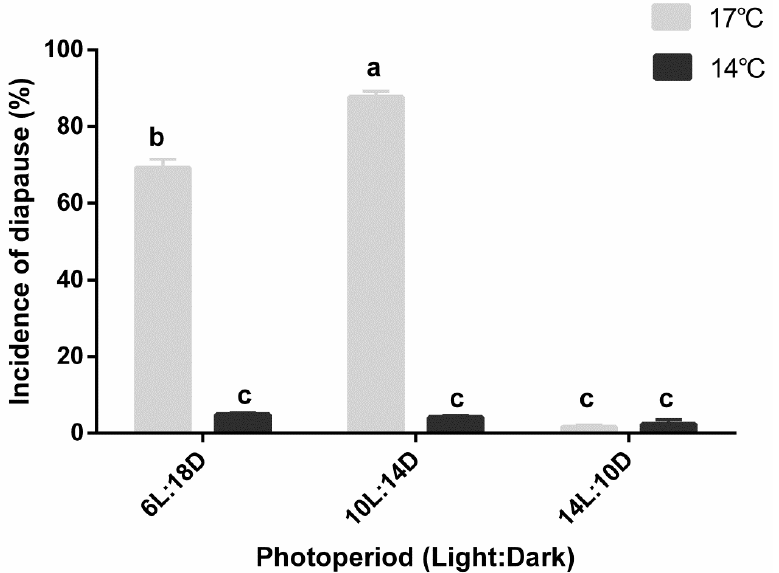
Figure 2. Effect of photoperiod on diapause induction in A. japonicus at different temperatures (mean ± SE%). Different letters indicate significant difference (two-way ANOVA, followed by Bonferroni’s multiple-comparison tests, p < 0.05) between different temperatures and photoperiods. Photoperiod, temperature, and their interactions all significantly influenced diapause induction in A. japonicus (temperature effect: F (1,37) = 1018.878, p < 0.001; photoperiod effect: F (2,37) = 330.119, p < 0.001; temperature × photoperiod interactions: F (2,37) = 273.080, p < 0.001).